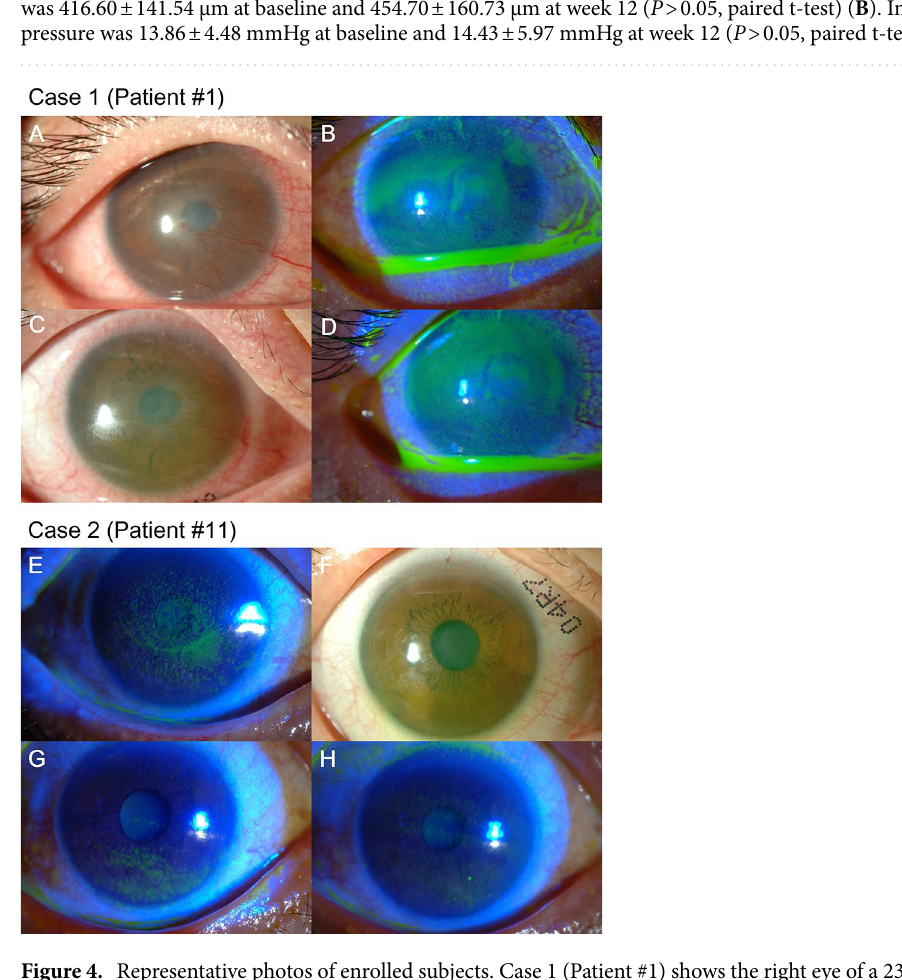
Figure 3. Safety outcomes of the LK scleral lens clinical trial. Endothelial cell density was 2931.4 ± 290.2 cells/ mm 2 at baseline and 2720.1 ± 436.5 cells/mm 2 at week 12 ( P > 0.05, paired t-test) ( A ). Central corneal thickness